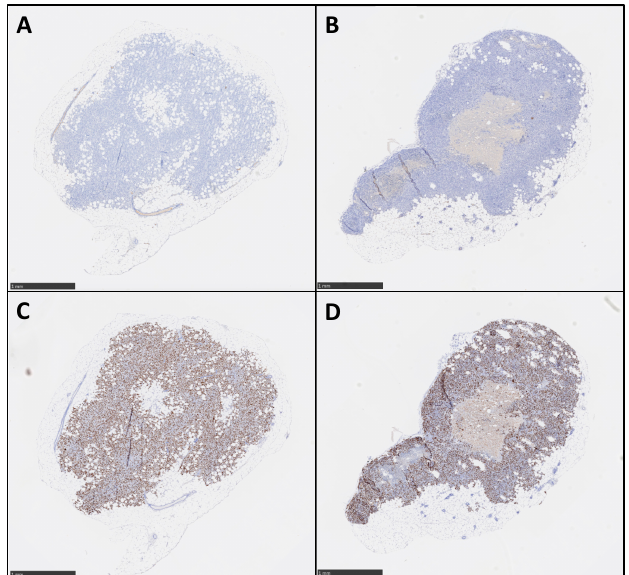
Figure 2. Ex vivo proliferation analysis of M113 melanoma xenograft tumors . M113 PD-L1+ ( A , C ) and M113 WT ( B , D ) melanoma tumor proliferation was examined on formalin-fixed and paraffin-embedded histologic sections after immunohistochemical staining with mouse anti-human Ki67 mAb ( C , D ) or mouse IgG1 κ isotype control ( A , B ). Data are representative of 4 different M113 PD-L1+ and M113 WT tumors. Scale bars = 1 mm.